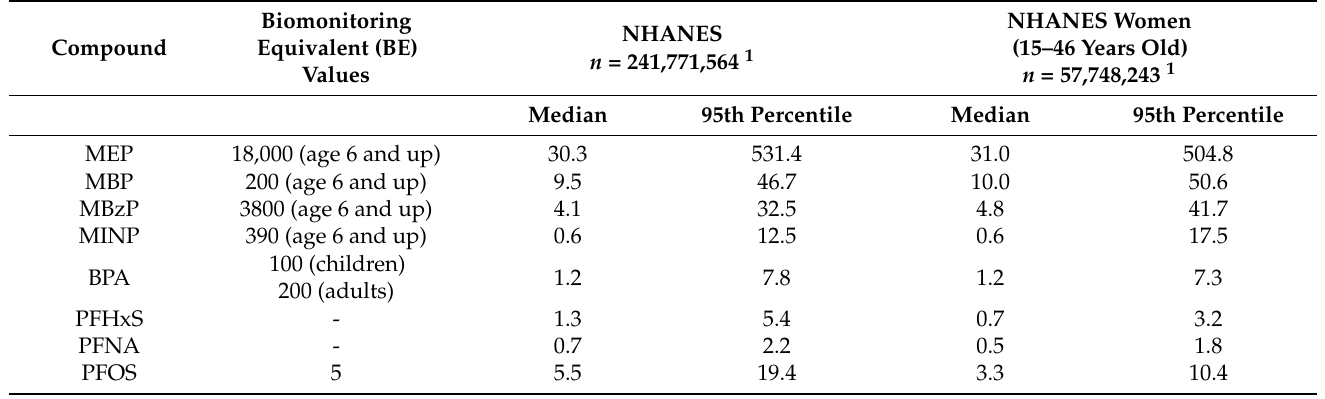
Table 2. Summary statistics (median, 95th percentile) for MIX N compounds for levels ( µ g/L) in urine (phthalates and BPA) and plasma (PFAS) as documented by NHANES (2011-16). Biomonitoring guidance values ( µ g/L) are provided for comparison. The minimum guidance value is displayed if more than one is given (https://biomonitoring.shinyapps.io/guidance/ (accessed on 25 January